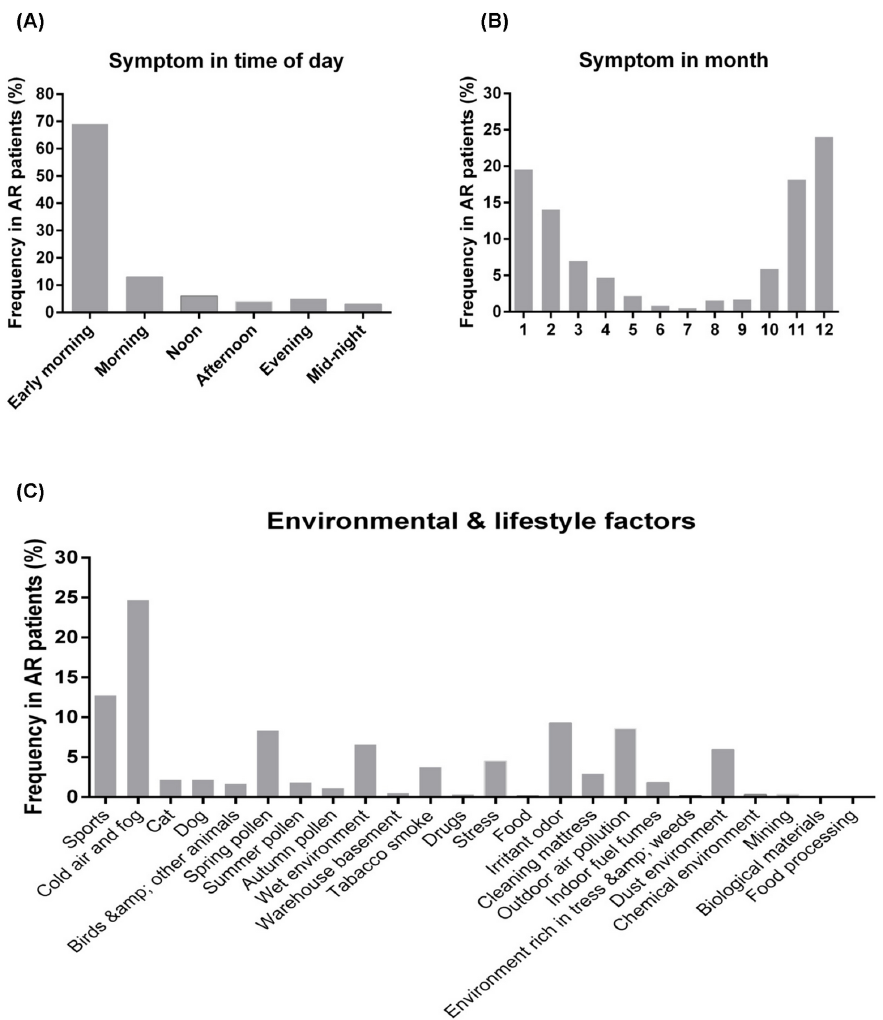
Fig. 4. Trigger factors of AR were shown in three categories: time of day (A), season (B), and common 24 environmental/lifestyle factors (C). Bar charts showed the percentage of the selection frequency of individual factor under each